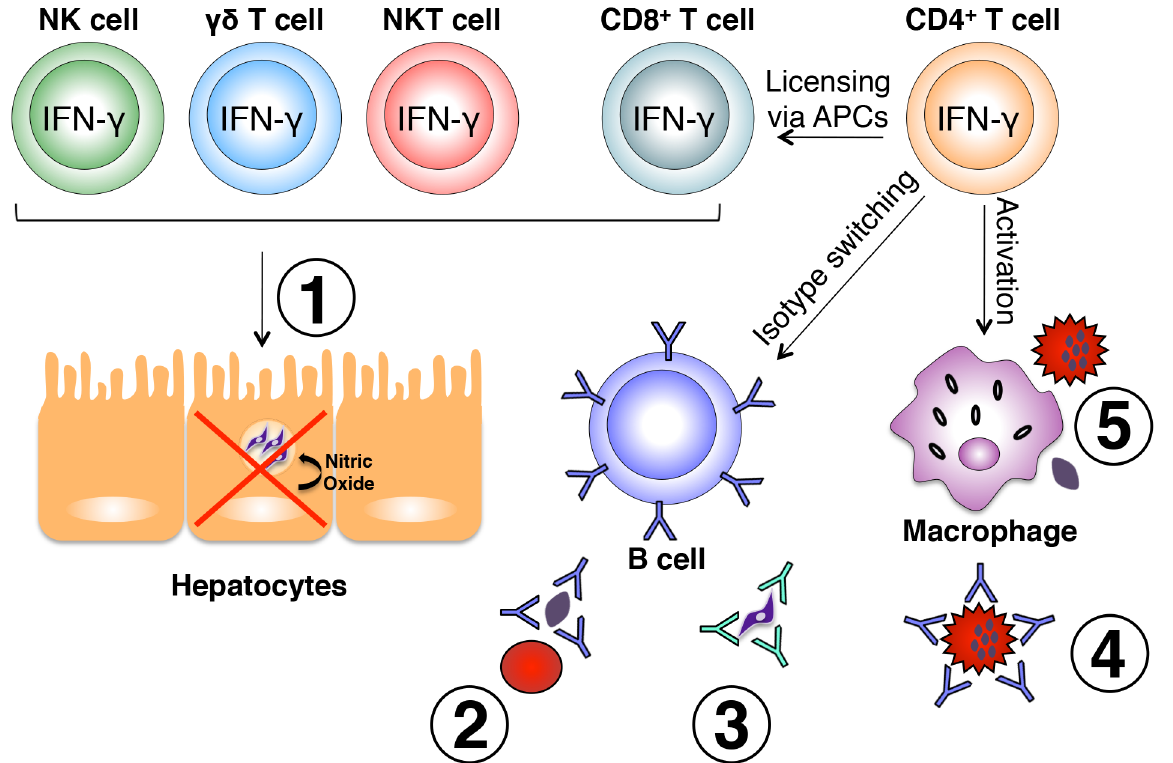
Fig 1. Effector mechanisms induced by IFN- γ during malaria. Various immune cell subsets produce IFN- γ in response to Plasmodium infection. NK, γδ , and NKT cells are largely responsible for early production of IFN- γ in response to liver and blood stages of the parasite and play a role in early control of parasite growth. IFN- γ -producing CD8 + T cells have also been shown to limit intrahepatic parasite growth through an IFN- γ -inducible, nitric oxide-dependent mechanism ( 1 ). Once an adaptive immune response is initiated, IFN- γ produced by CD4 + T cells optimally activates CD8 + T cells, B cells, and macrophages. IFN- γ influences isotype switching in B cells leading to production of cytophilic antibodies capable of binding free parasites and blocking red blood cell invasion ( 2 ), mediating parasite clearance through opsonization ( 3 ), and binding the surface of infected red blood cells promoting antibody-dependent phagocytosis ( 4 ). Production of IFN- γ from CD4 + T cells also optimally activates macrophages to phagocytose infected red blood cells and free parasites ( 5 ). All of these mechanisms are important for optimal control of parasite growth during Plasmodium infection.